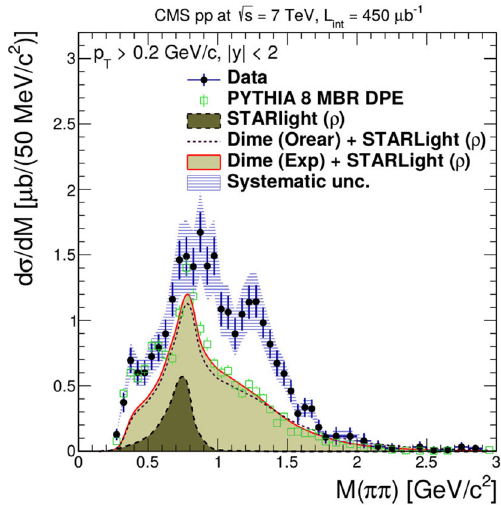
Fig. 5 Differential cross section measured by the CMS Collaboration as function of the pion pair invariant mass (Figure taken from Ref. [5])